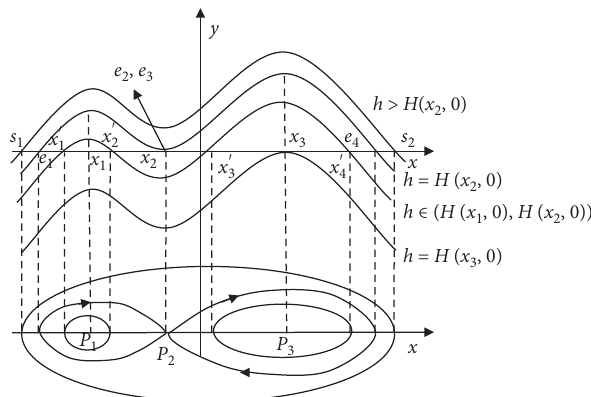
( x ) function curve and trajectories when h